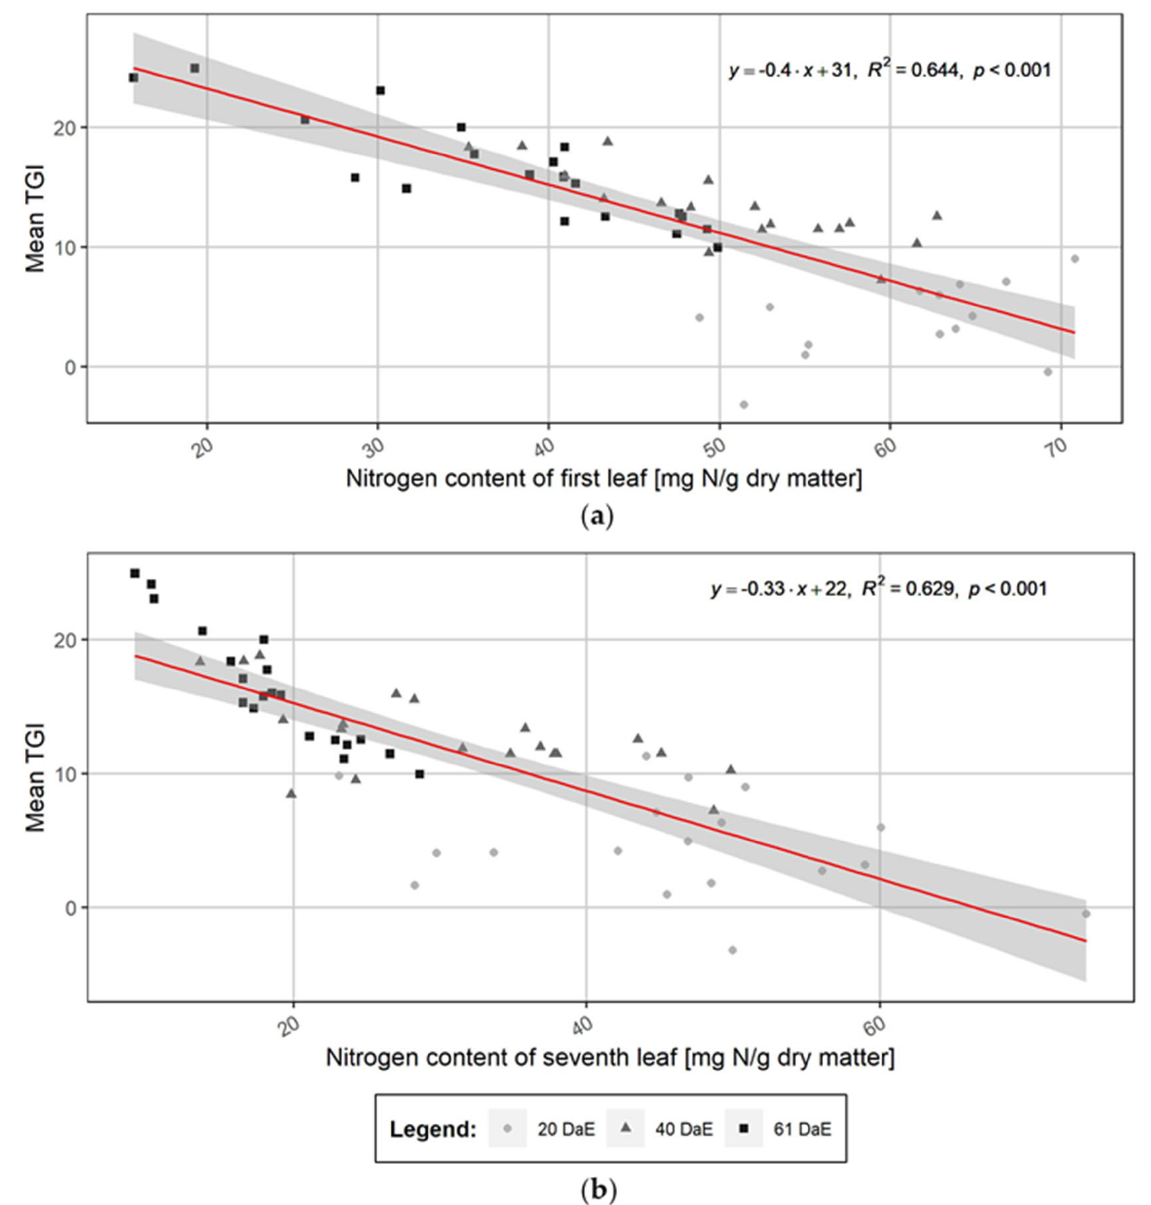
Figure 6. Relationships between the mean TGI measured at plant level and: ( a ) the N content of the 1st fully developed leaf located at the apex of the main vine ( n = 52 plants); and ( b ) the N content of the 7th fully developed leaf starting from the apex of the main vine ( n = 58 plants) in water yam cv raja ala grown in the presence of different N fertilizations and sampled at 20, 40 and 61 days after emergence (DaE). The form of the symbols indicates the sampling dates, and the grey band indicates the 95% confidence interval.